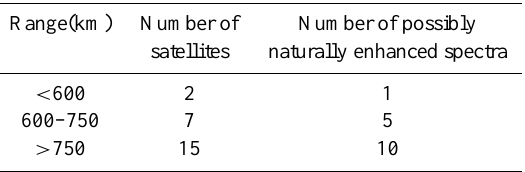
Table 2. The number of satellites and possibly naturally en- hanced spectra found in the region covered by the ESR beam